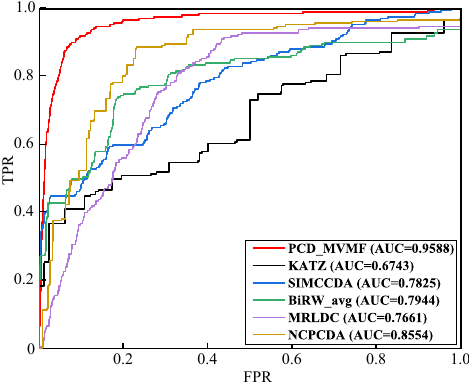
Fig. 2 ROC curves of PCD MVFM and other computational methods based on LOOCV.